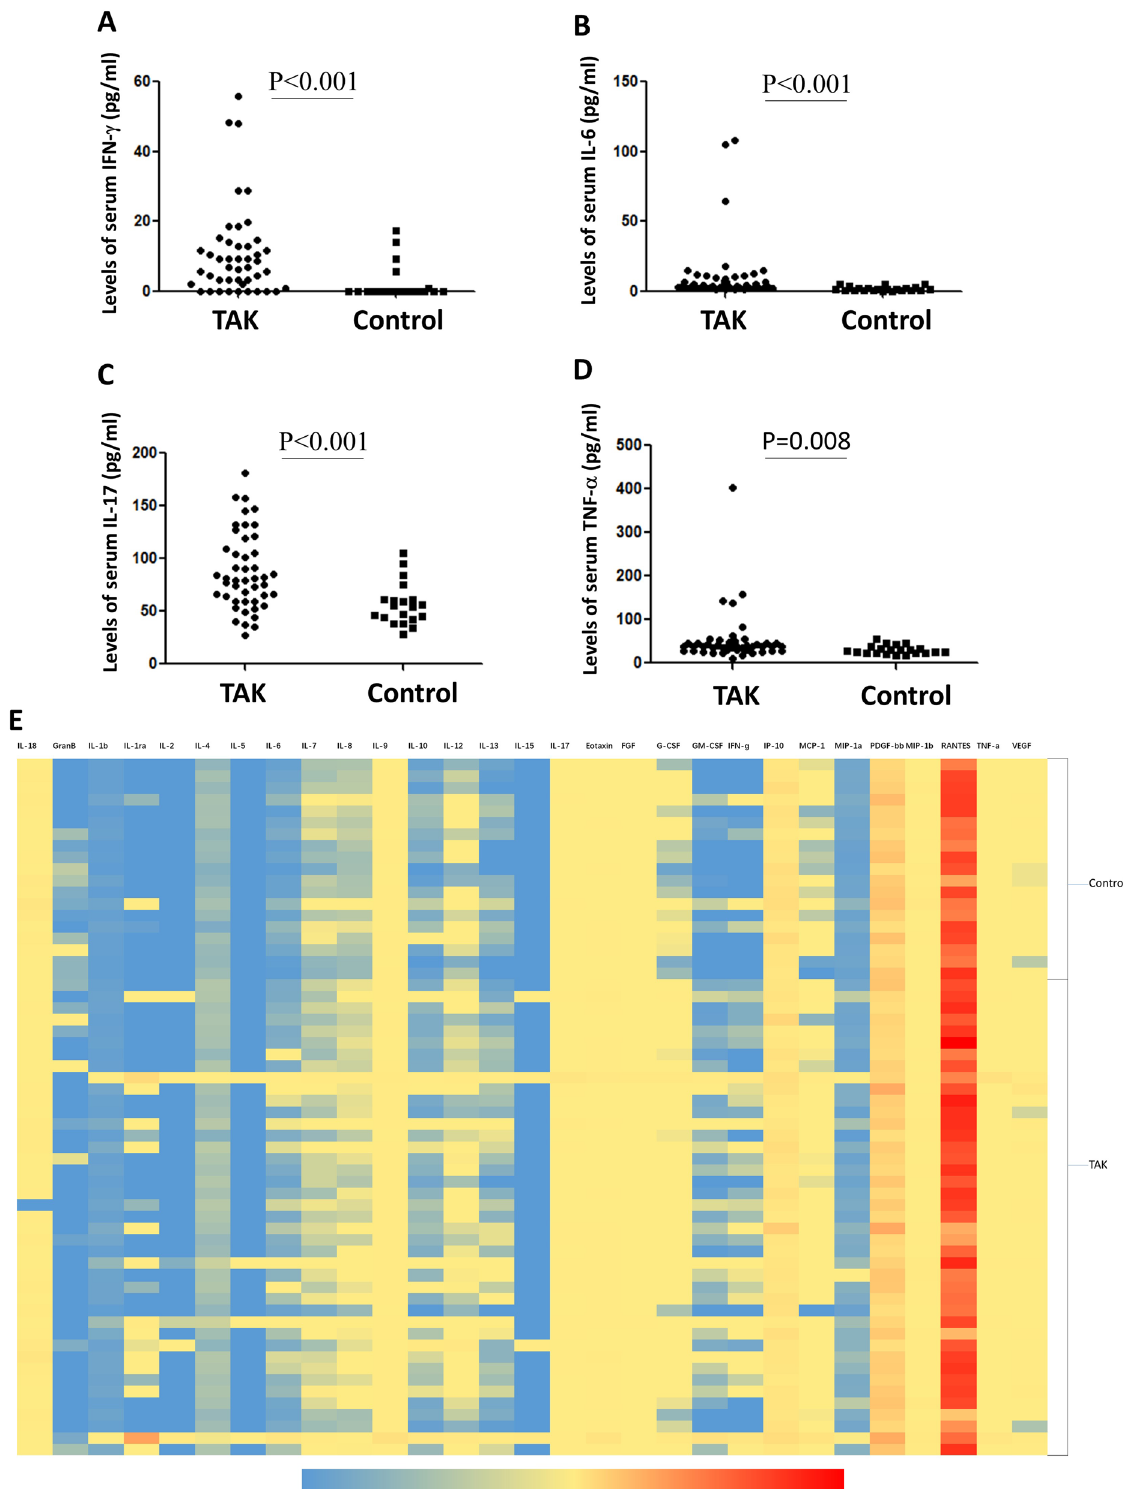
Figure 1. Serum cytokine levels in patients with 42 TA patients and 18 healthy controls. ( A ) The level of serum IFN-γ in TA patients was significantly higher than that in healthy controls ( P < 0.001); ( B ) the level of serum IL-6 was significantly higher than that in the control group ( P < 0.001); ( C ) the level of serum IL-17 in Ta Group was significantly higher than that in the control group ( P < 0.001); ( D ) the level of serum TNF-α in Ta Group was significantly higher than that in the control group ( P = 0.008); ( E ) the heatmap of serum cytokines in peripheral blood of 42 patients with TAK and 18 healthy